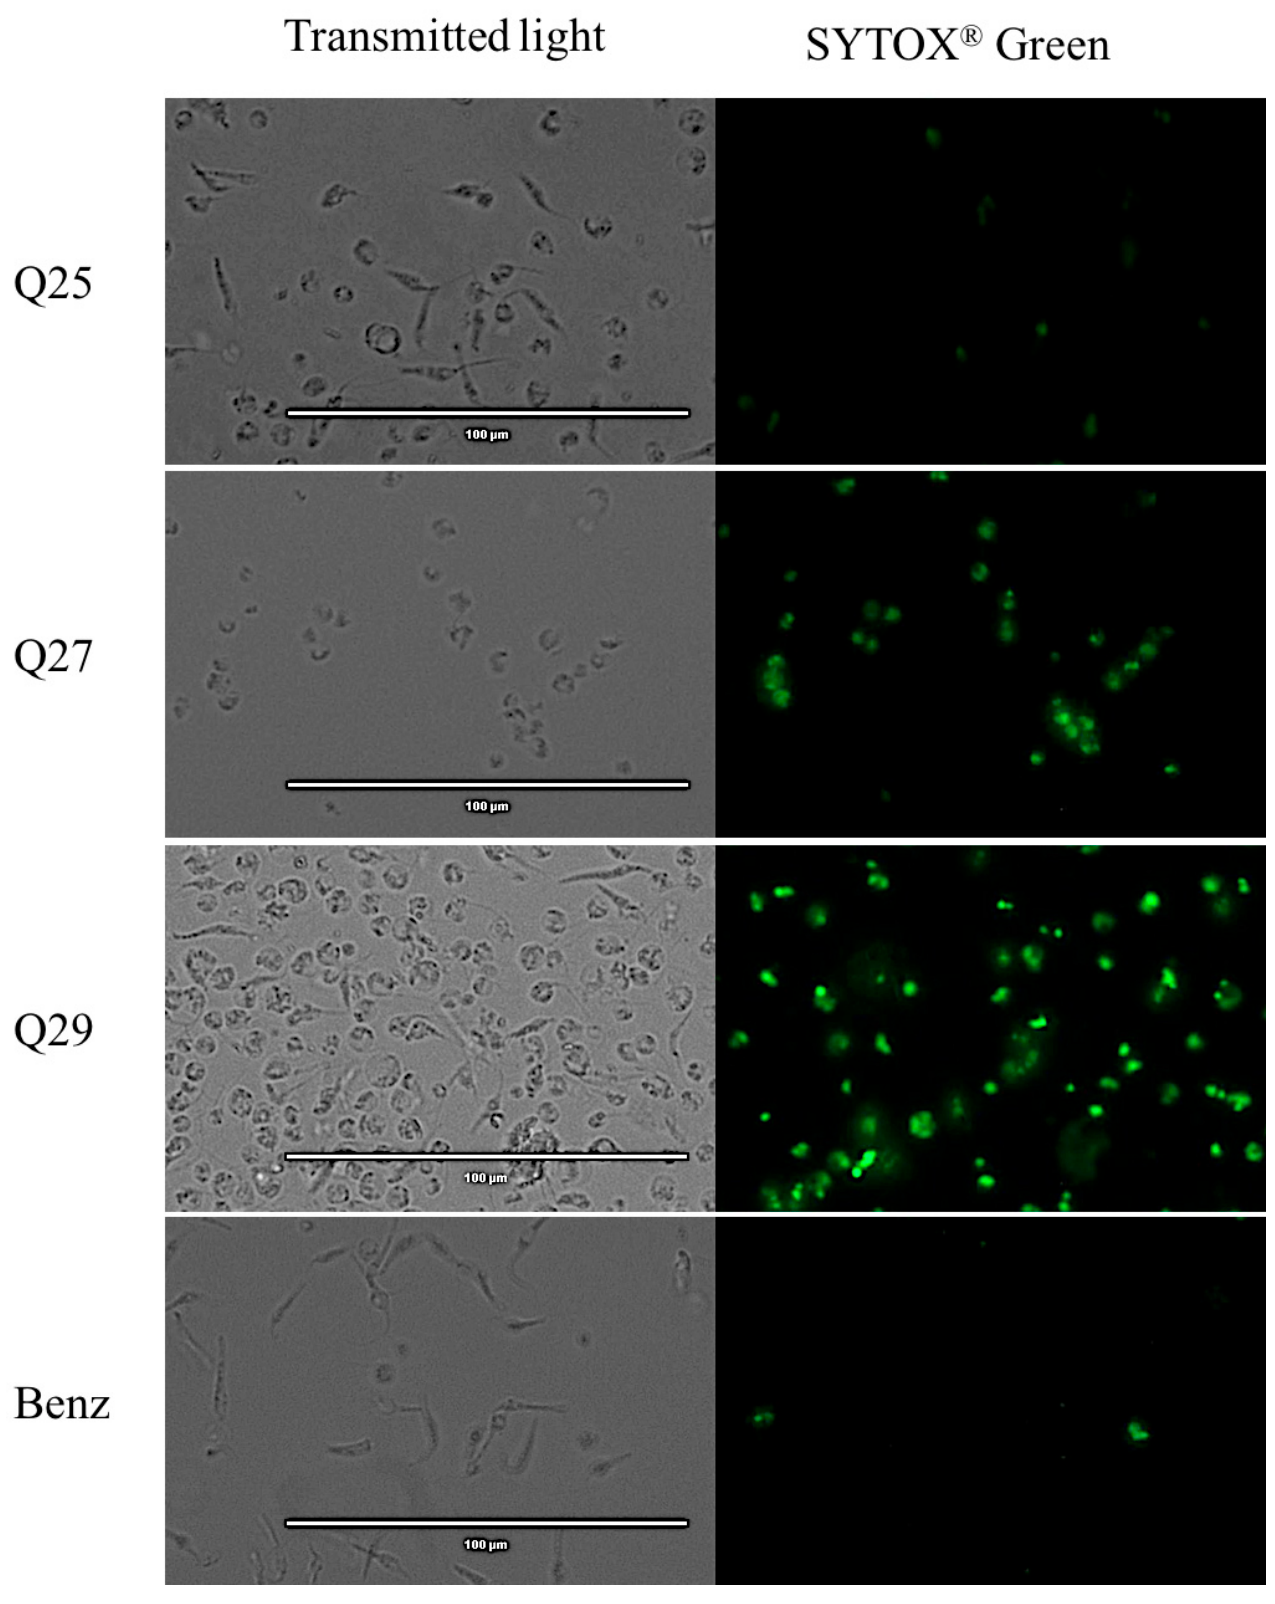
Figure 4. Detection of plasmatic membrane permeability by SYTOX ® Green staining. Epimastigotes after 24 h of incubation with the IC 90 of the acrylonitriles. Images were captured using an EVOS FL Cell Imaging System (40×). Scale-bar : 100 µm. NC: negative control; Benz: benznidazole.